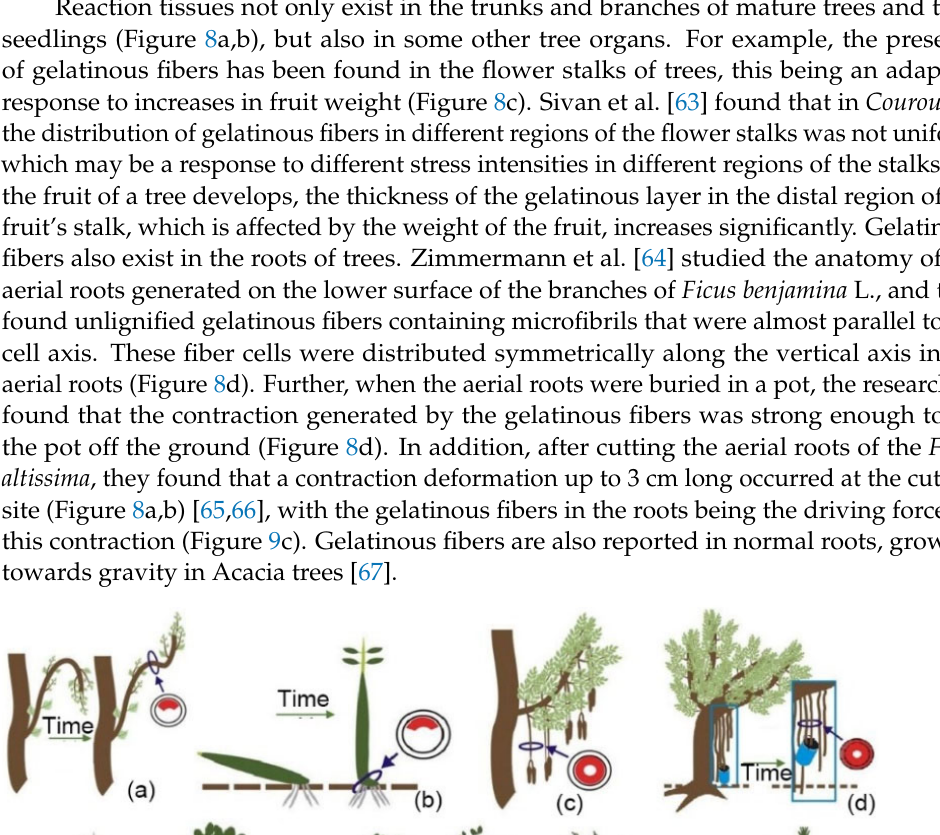
Figure 9. ( a , b ) Complete and severed grounded roots of Ficus altissima , with its cut surfaces sepa ‐ rated by a distance of 3 cm (double ‐ headed white arrow). Arrows indicate identifying marks [66]; ( c ) Secondary xylem of transected root * = parenchyma. ▲ = gelatinous fibers.